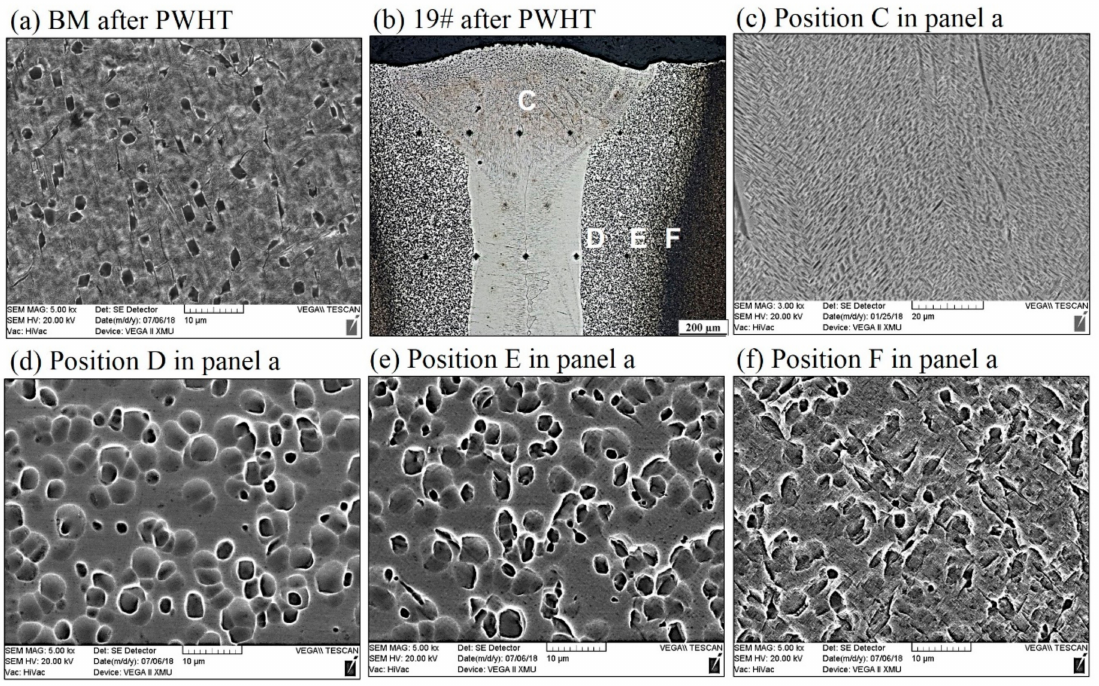
Figure 9. Microstructures of ( a ) BM after PWHT, and ( b ) cross sections of as-welded Ti55531 joint